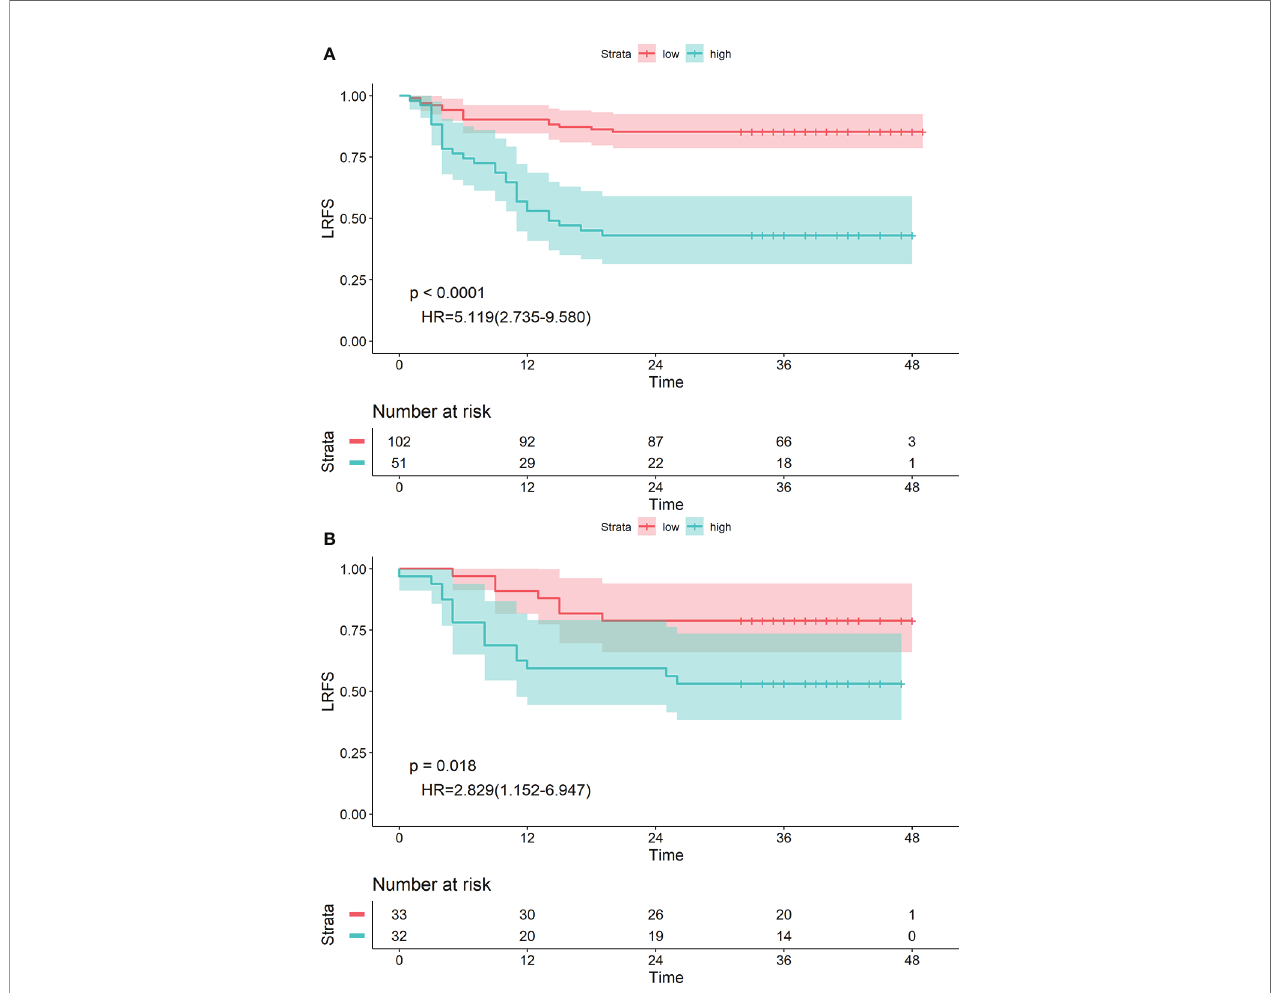
FIGURE 6 | Kaplan-Meier survival analyses of high-risk and low-risk groups divided by the radiomics nomogram in the training (A) and validation (B)